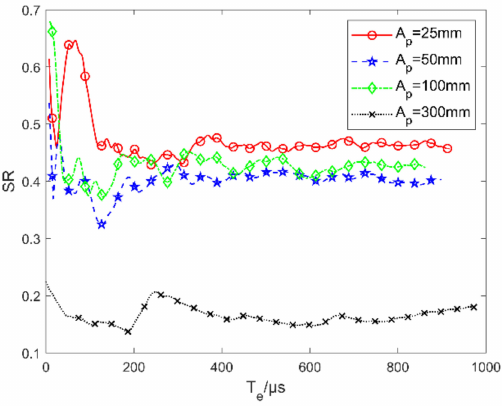
Figure 19. Variation of Strehl ratio (SR) with exposure time ( T e ) and aperture